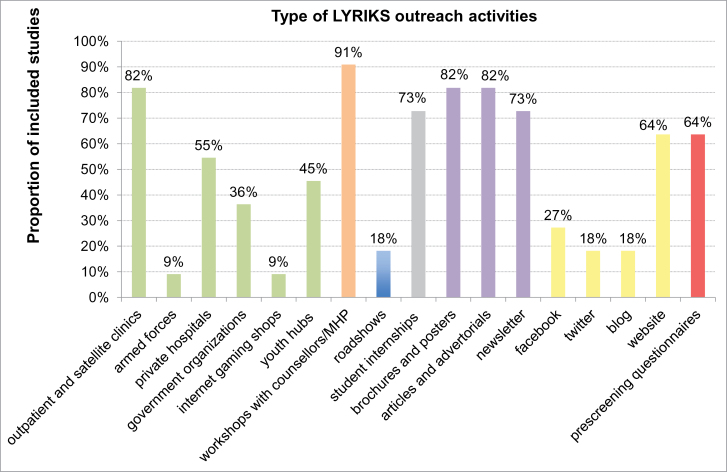
Type of Outreach LYRIKS activities adopted by each of the CHR studies included in the current database. Outreach activities were defined and clustered as indicated in the community engaged framework adopted by the LYRIKS CHR study.15 These included the following domains: (A) screening assessments and recruitment, in green (outpatient and satellite clinics, armed forces, private hospitals, government organizations, internet gaming shops, and youth hubs); (B) workshops involving various community partners such as counsellors and mental healthcare professionals, in orange; (C) roadshows, in blue; (D) student internships, in gray; (E) print media, in violet (brochures and posters, articles and advertorials, newsletter); (F) social media, in yellow (facebook, twitter, blog, website).15 The LYRIKS domains were further expanded with the addition of (G) prescreening questionnaires, in red. MHP, Mental health professionals.